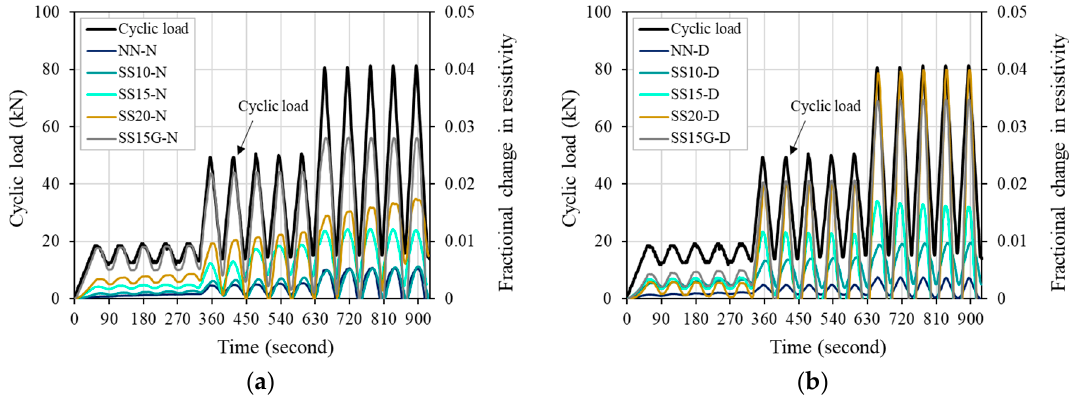
Figure 2. FCR response of concrete: ( a ) normal series; and ( b ) dry series.